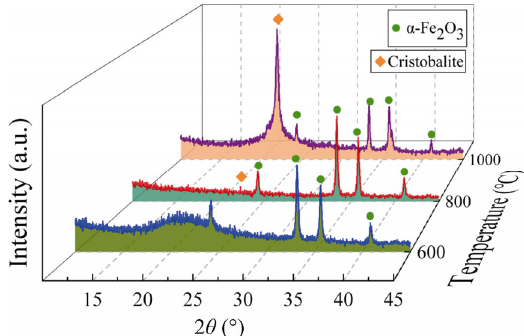
Fig. 5 XRD patterns of the α-Fe 2 O 3 @SiO 2 pigments with different calcination